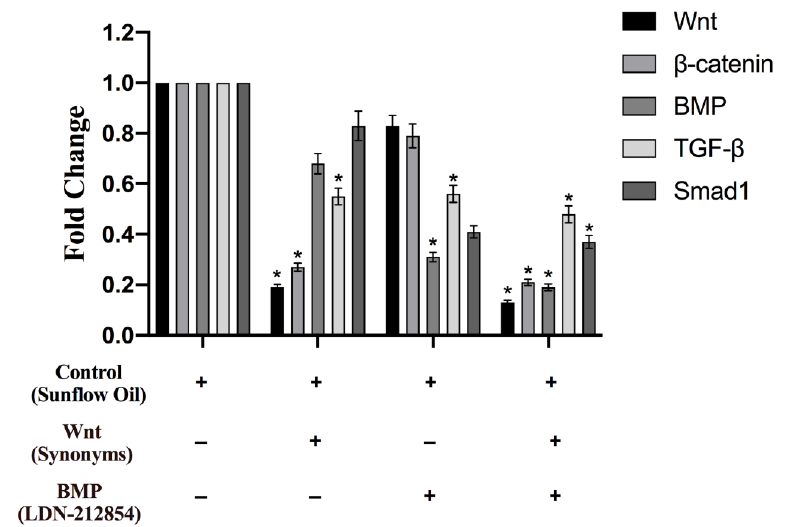
Figure 7. The qRT-PCR analyzed the relative gene expression under the Wnt and BMP singles, which were blocked with the antagonist of Wnt and BMP. The GAPDH was used as a reference gene normalize q-PCR data. Bars represent the standard and error, * p < to normalize q-PCR data. Bars represent the standard and error., * p < 0.05.